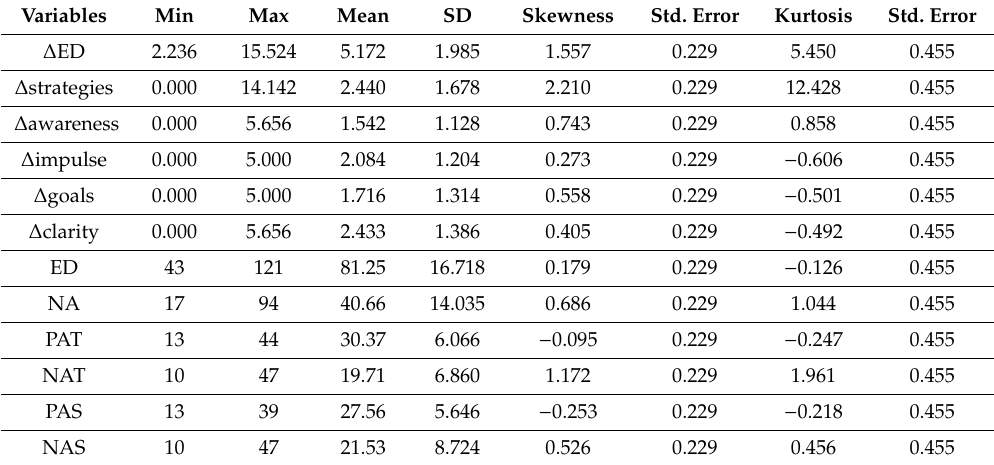
Table 3. Descriptive statistics / chronic disease group ( n = 137).